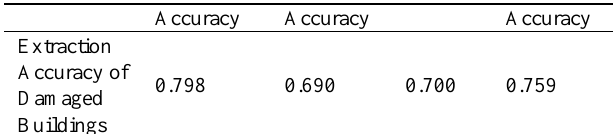
Table 3 Accuracy evaluation of decision tree classification method